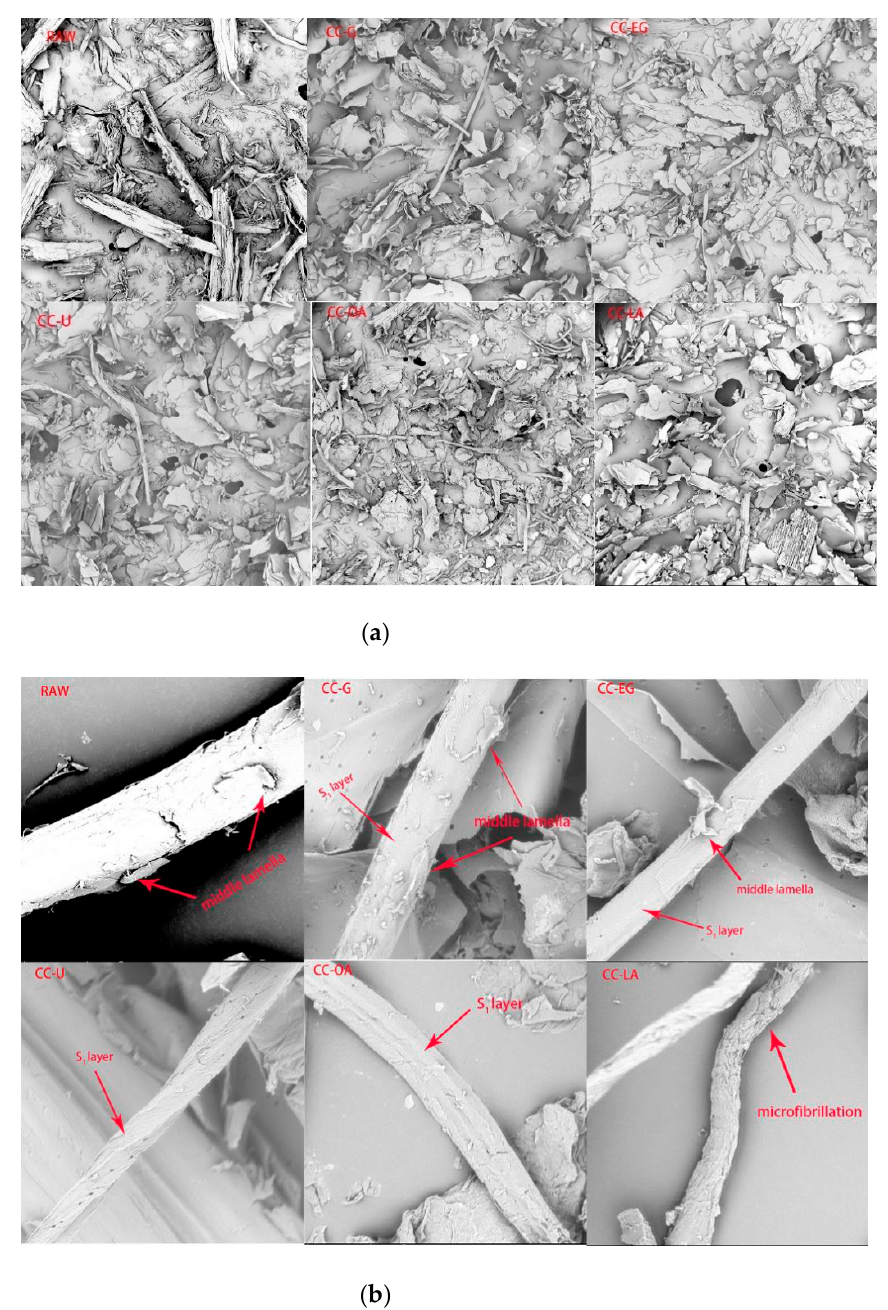
Figure 2. SEM images of the original and pretreated bagasse at different magnifications: ( a ) 200×; ( b ) 3000×.